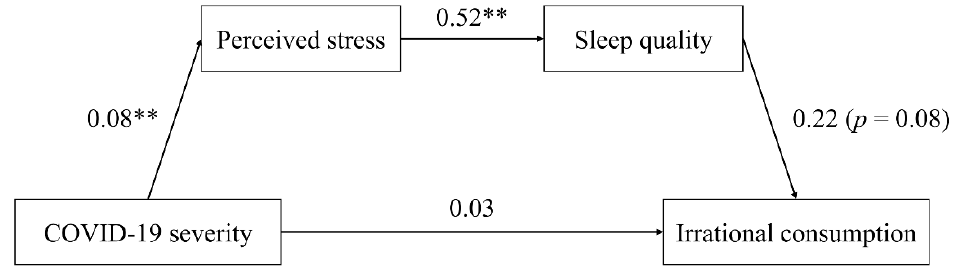
Figure 5. Mediation analysis: perceived stress and sleep quality as mediators (Study 2, higher scores of sleep quality scale indicates worse the sleep quality). ** represents significance at the 0.01 level.